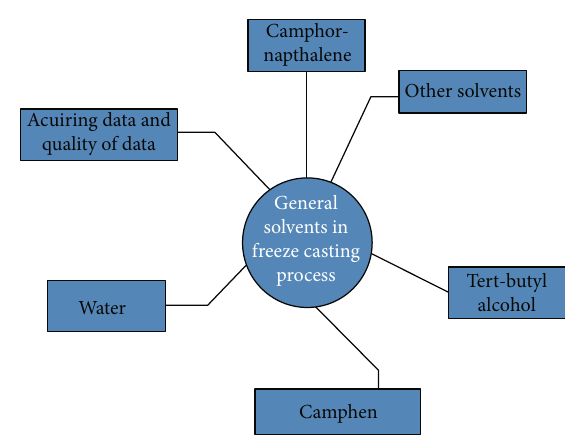
Figure 3: General